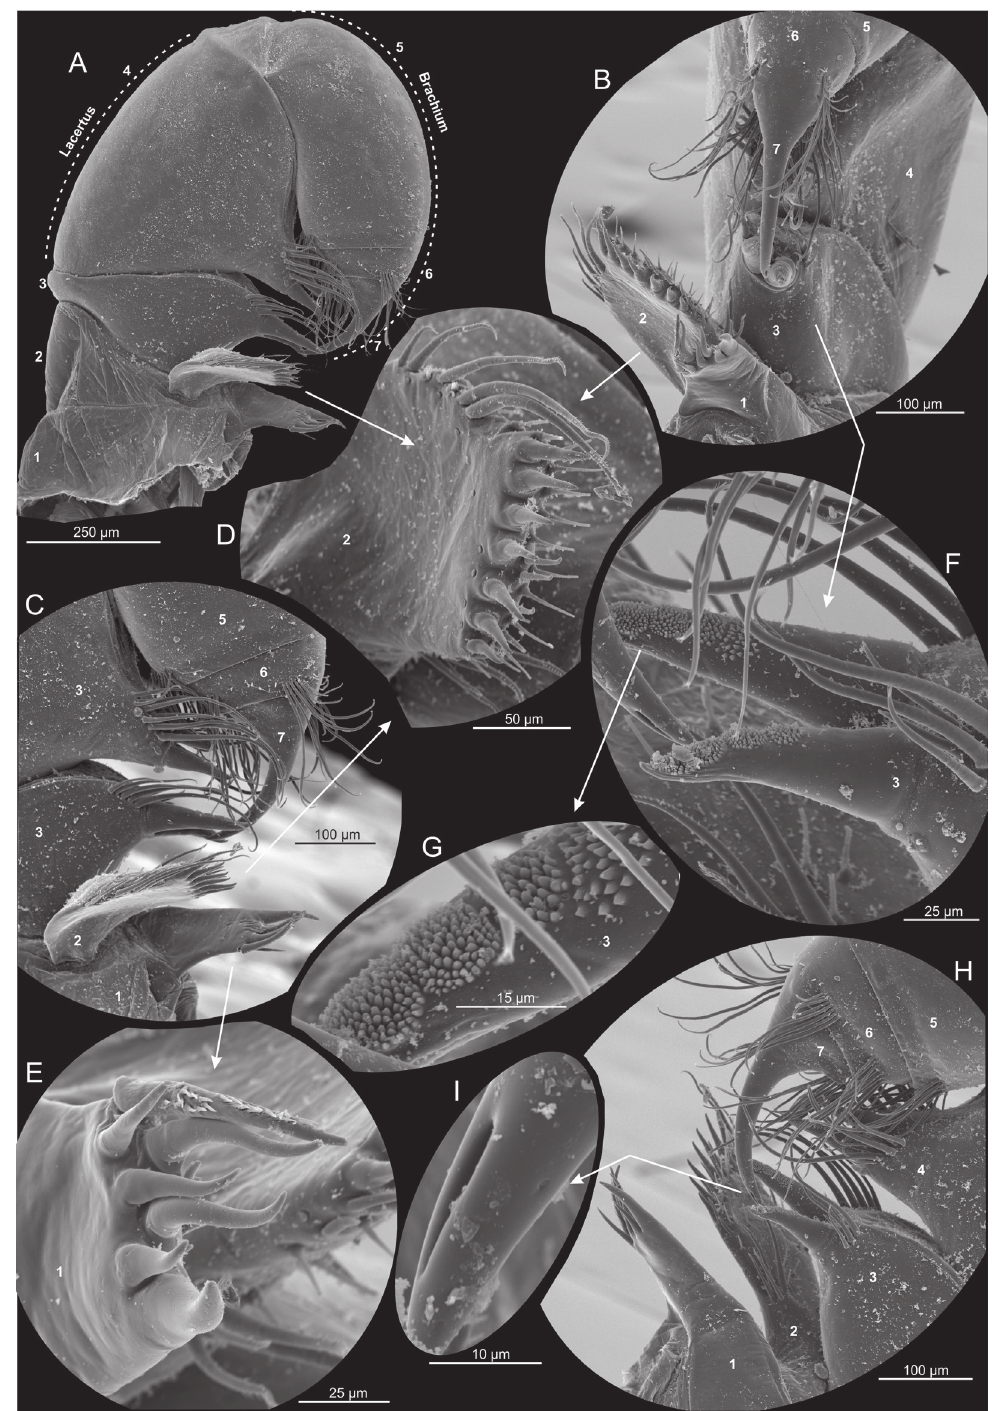
Fig. 6. Xibalbanus cozumelensis sp. nov., paratype (ZMUC-CRU-4792), maxilla 1 (mx1), left side, scanning electron microscopy. A . Complete mx1 from anterior. B . Median view. C . Close-up of median structures (e.g., endites) and distal claw from anterior. D . Distal setation of plate-like endite of segment 2 seen from ‘below’. E . Distal setation of endite of segment 1 seen from ‘below’. F . Close-up of two robust, broad-based cone-shaped setae of segment 3. G . Close-up of papillae of cone-shaped seta. H . Close-up of median structures (e.g., endites) and distal claw from posterior. I . Fang-like claw with visible subterminal duct